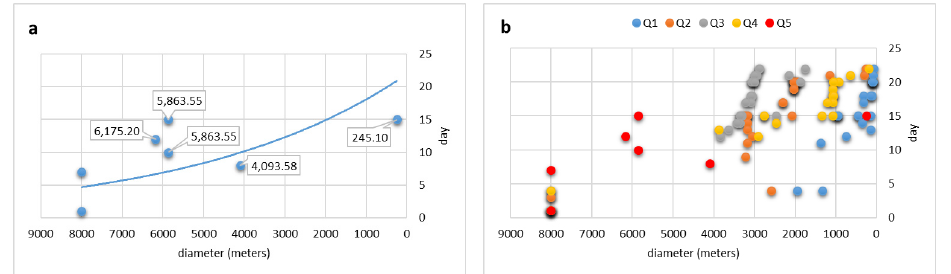
Figure 5. Spatiotemporal evolution of the geo-consensus on question 5 ( a ); and the geo-consensus related to the whole exercise ( b ).